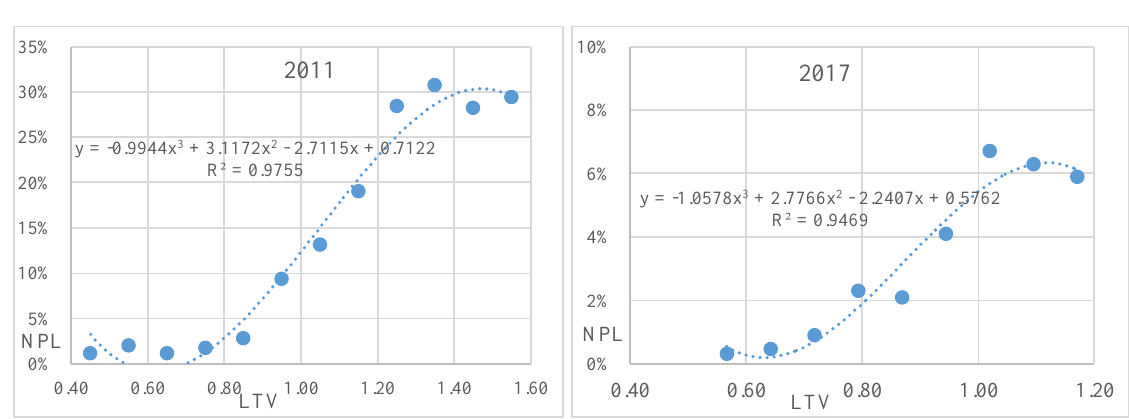
Figure 5. Credit history and NPL’s distributions.